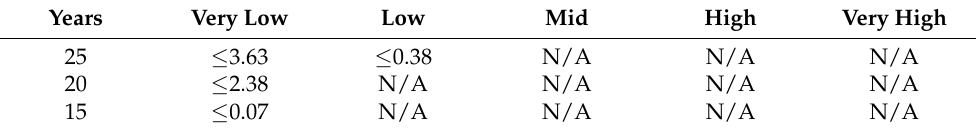
Table 16. Floating Discount Rate Pure